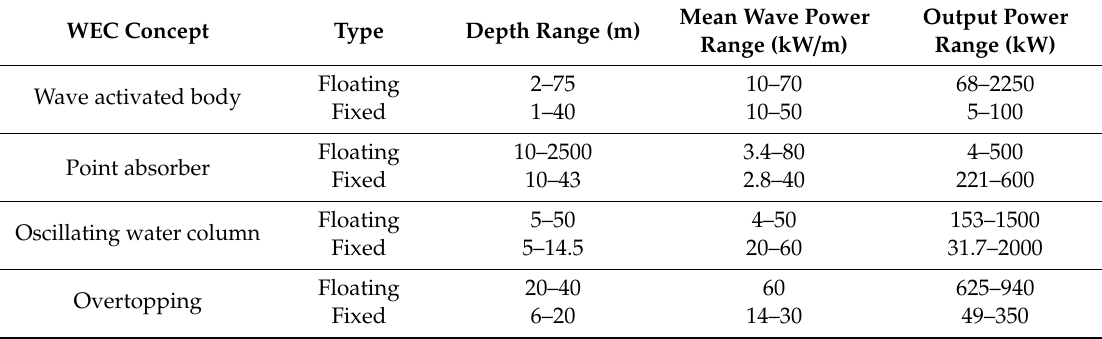
Table 2. Summary of operating depths, mean power ranges, and output power ranges for wave energy converter (WEC)